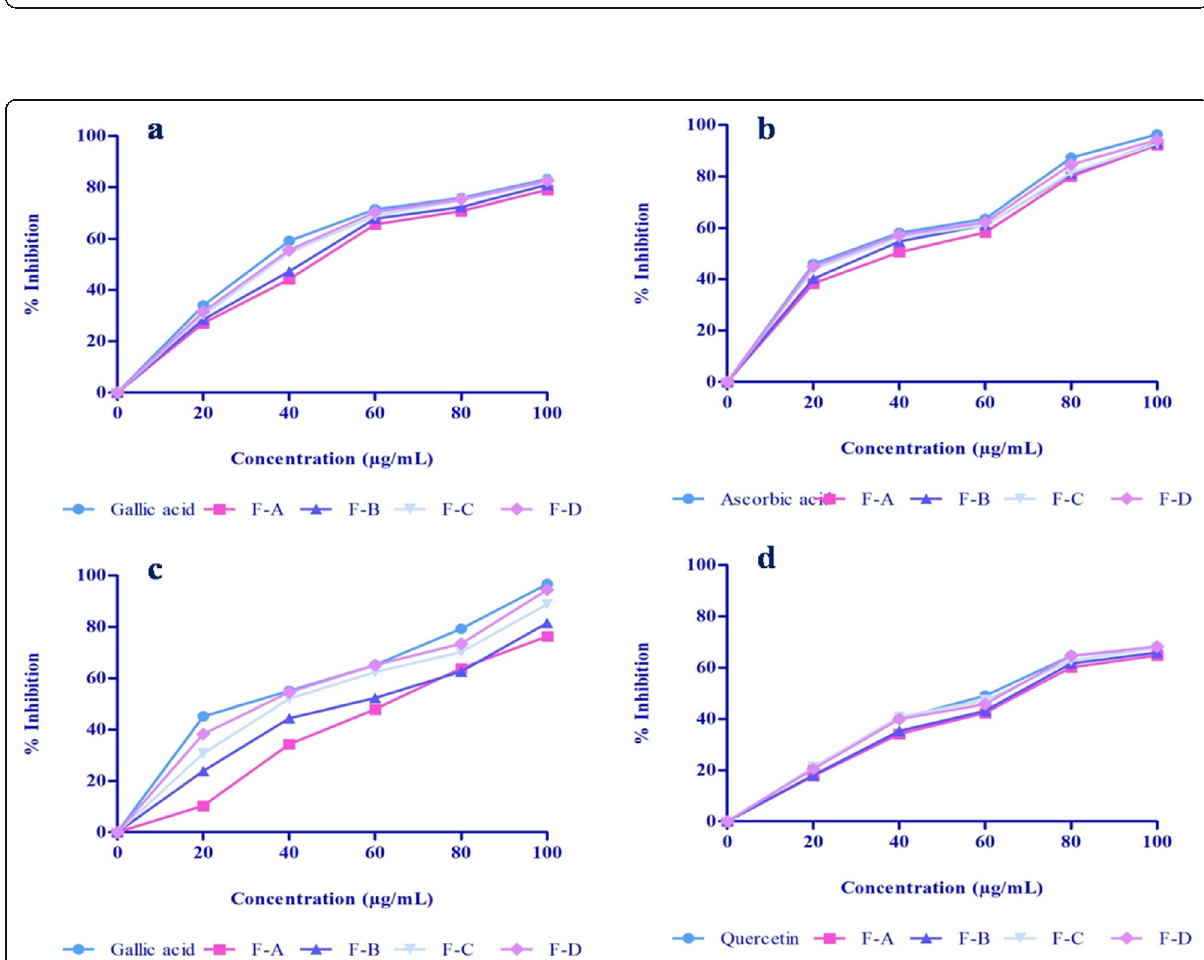
Fig. 2 a DPPH, b ABTS, c H 2 O 2 , and d superoxide radical scavenging activities of four pooled fractions and standards. The data demonstrates the mean of triplicates of five doses used in the